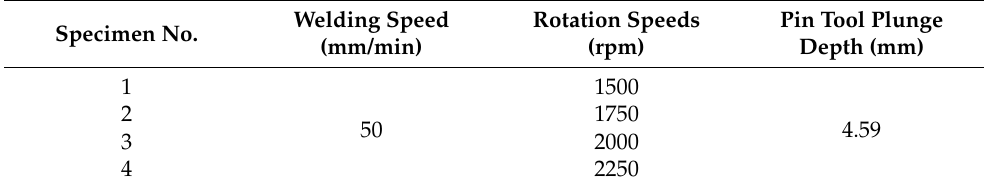
Table 5. Welding parameters of the SSFSW of 2A14 Al-alloy T-joints.